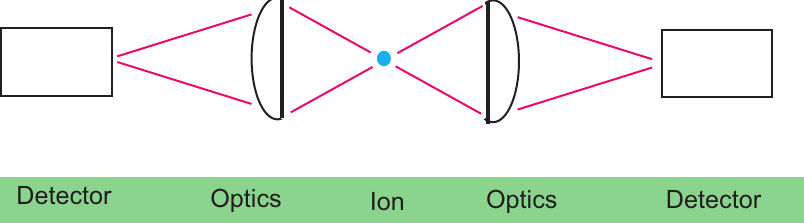
Figure 3. Schematic of optical detection of emission from an ion (center) by two large-solid angle collection systems imaging the object onto a